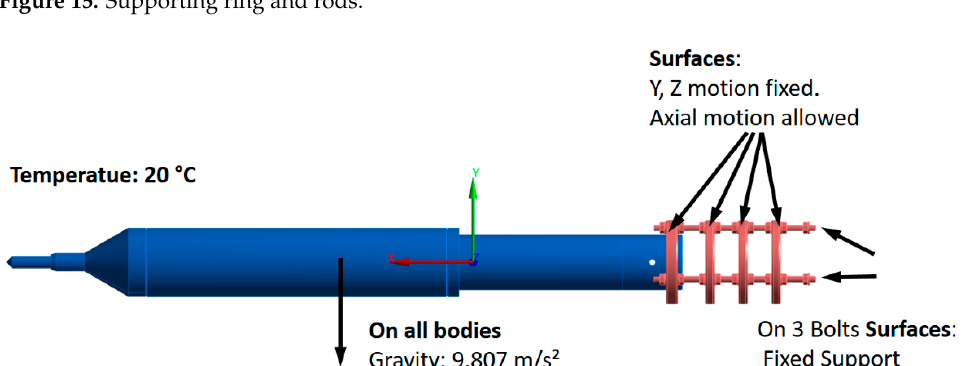
Figure 18. Deformation for one additional stiffening ring (case 1).